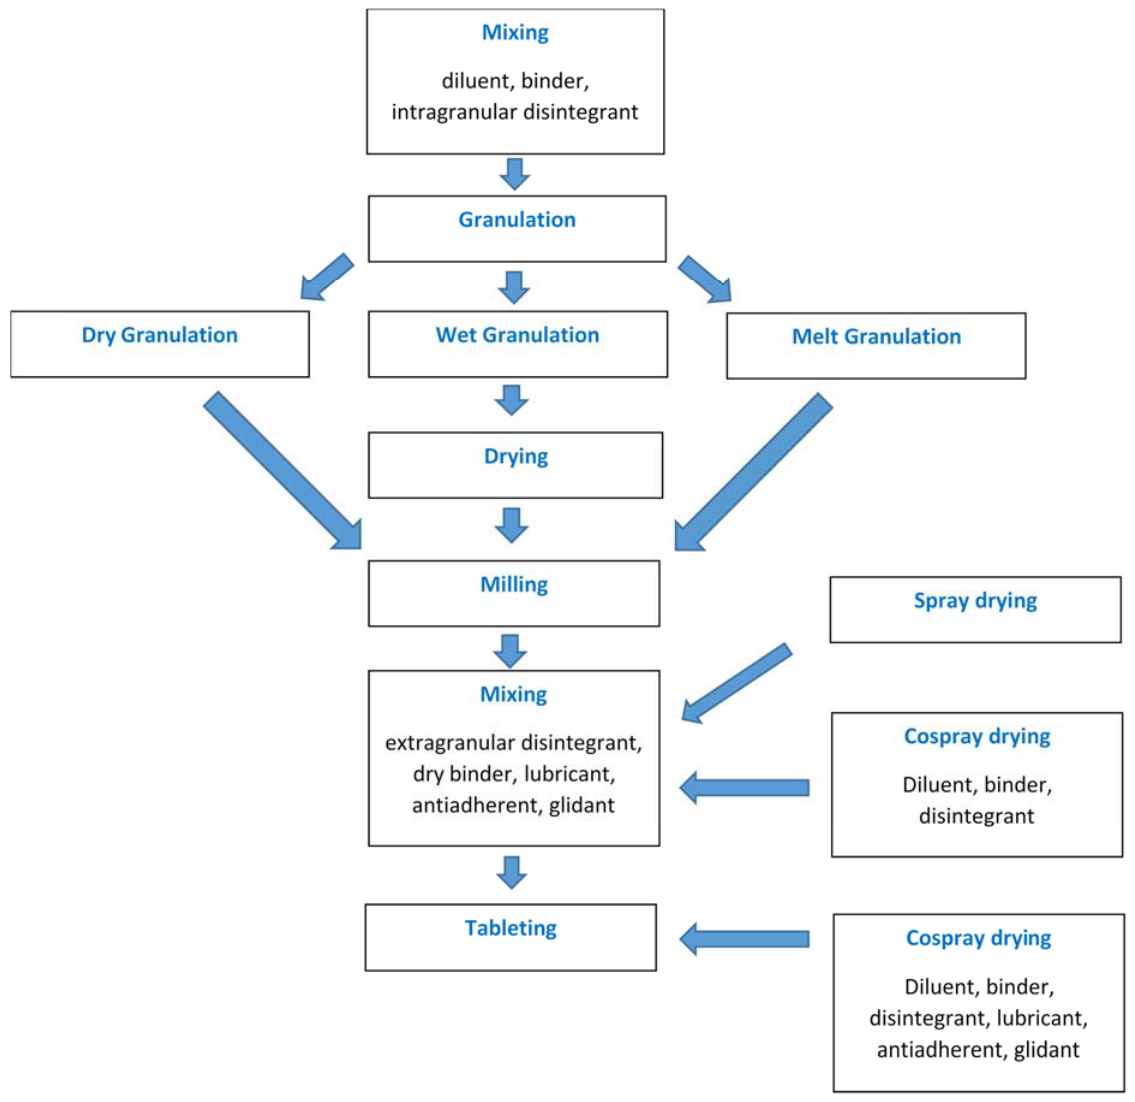
Figure 1. Unit operations employed in the production of tablets via granulation or spray/co ‐ spray drying.